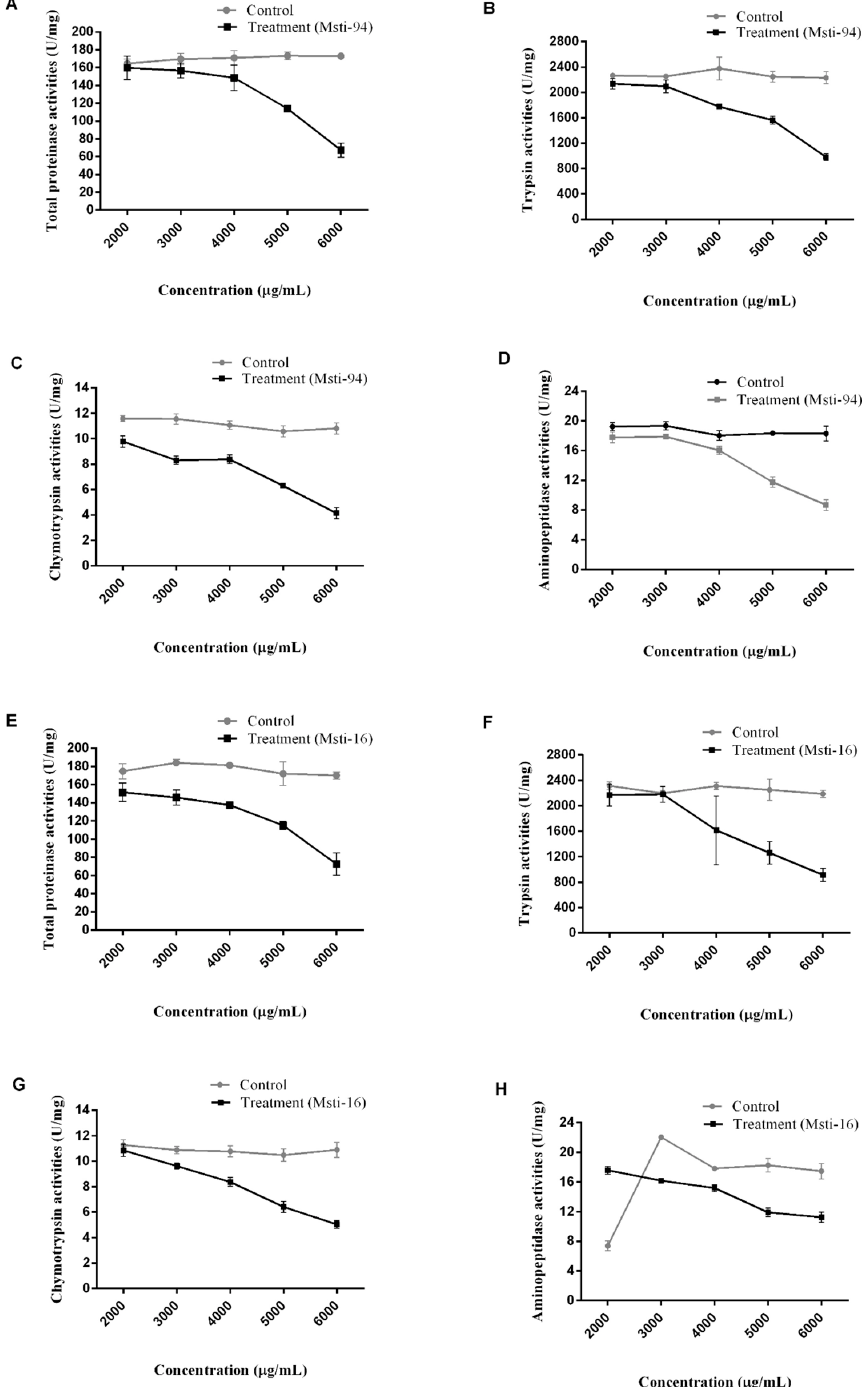
Figure 7. Activities of the four selected enzymes treated with different concentrations of Msti-94 and Msti-16 added to the artificial feed along with the control. Total proteinase vs. Msti-94 ( A ); trypsin vs. Msti-94 ( B ); chymotrypsin vs. Msti-94 ( C ); aminopeptidase vs. Msti-94 ( D ); proteinase vs. Msti-16 ( E ); trypsin vs. Msti-16 ( F ); chymotrypsin vs. Msti-16 ( G ); aminopeptidase vs. Msti-16 ( H ). The calculation method of the enzyme activity is based on the international calculation formula, and an enzyme activity unit (U) is defined as the reduction or production of 1 µ mol substrate in 1 min. Control refers to the group with the artificial feed without any inhibitors (non-induced bacterial sample), and treatment refers to the artificial feed with inhibitors.